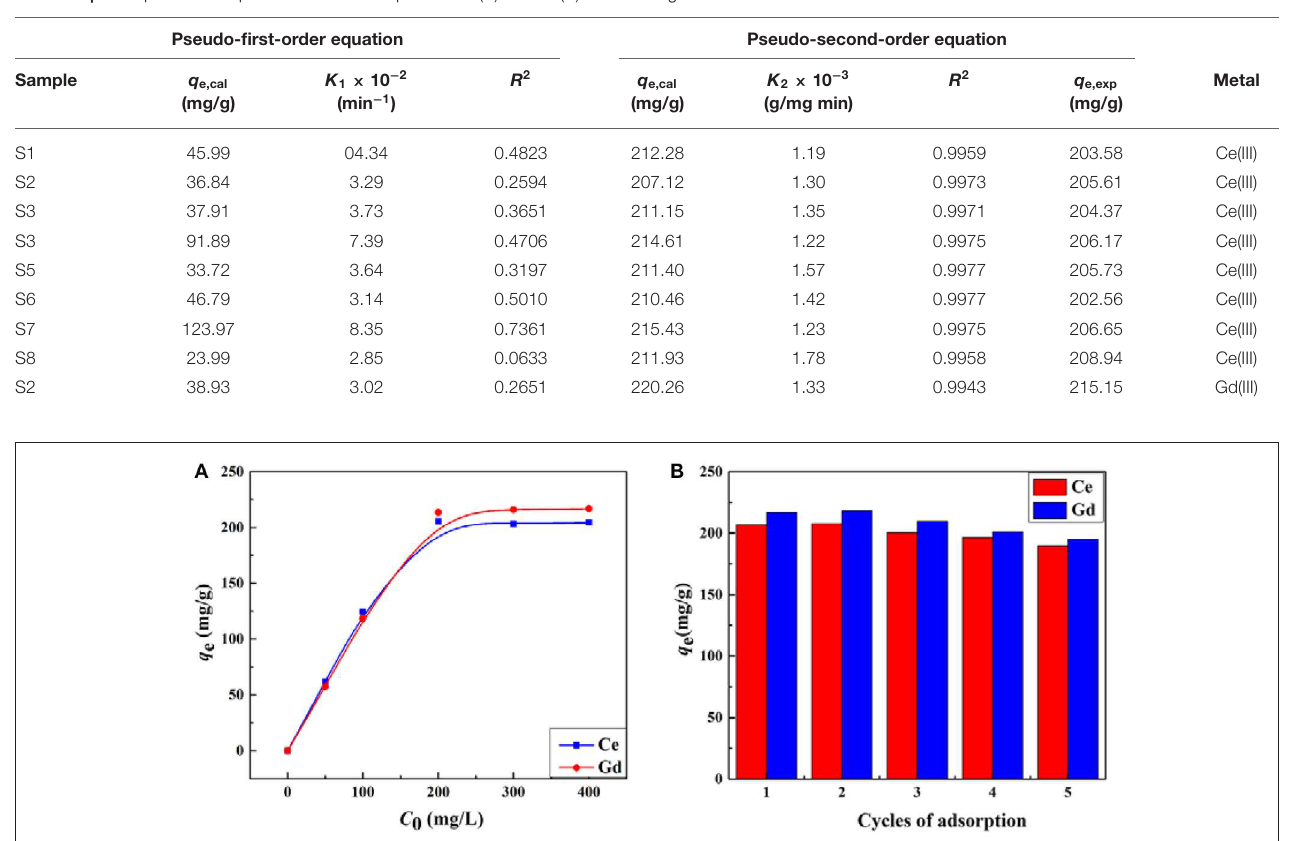
TABLE 2 | Adsorption kinetic parameters for adsorption of Ce(III) and Gd(III) onto CMC- g -PAM/ATP. Pseudo-first-order equation Pseudo-second-order